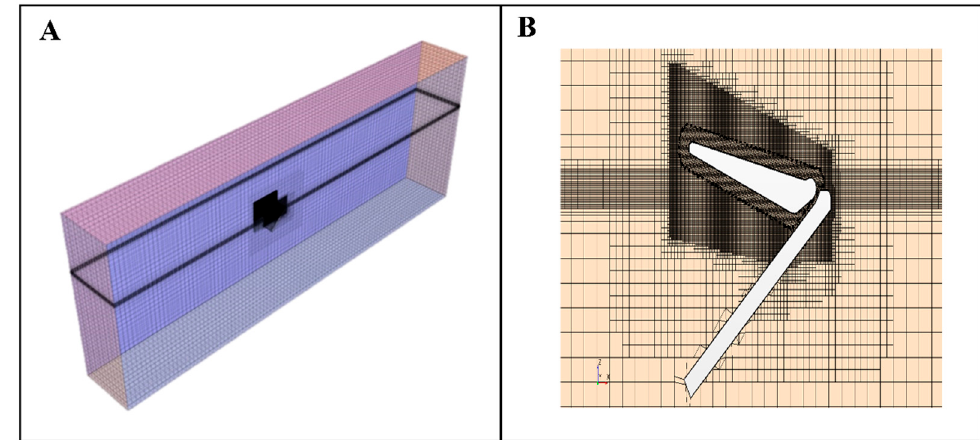
Figure 2. Mesh of the model ( A ), Mesh generation details of the WEC model ( B ).